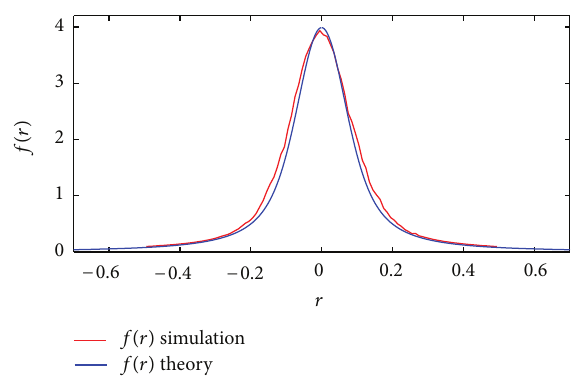
Figure 5: Comparison of theoretically derived (30) and numerically simulated error pdf for 𝜎 𝑒 = 0.1